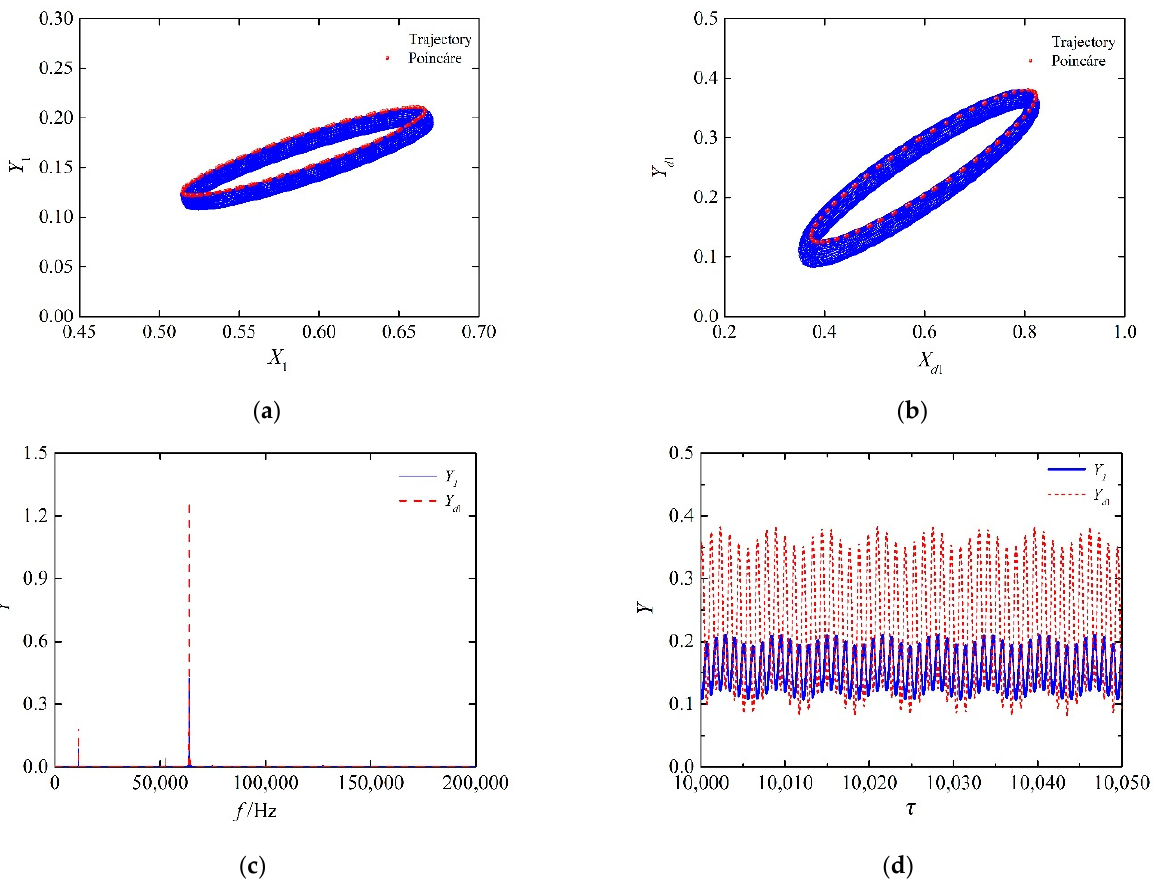
Figure 6. Quasiperiodic motion of the rod–fastened rotor at ω = 1000 rad/s: ( a ) orbit and Poincaré map at the left bearing station; ( b ) orbit and Poincaré map at the left disk station; ( c ) comparison of spectrogram at the left disk and left bearing stations; ( d ) comparison of the time series diagram at the left disk and left bearing stations.